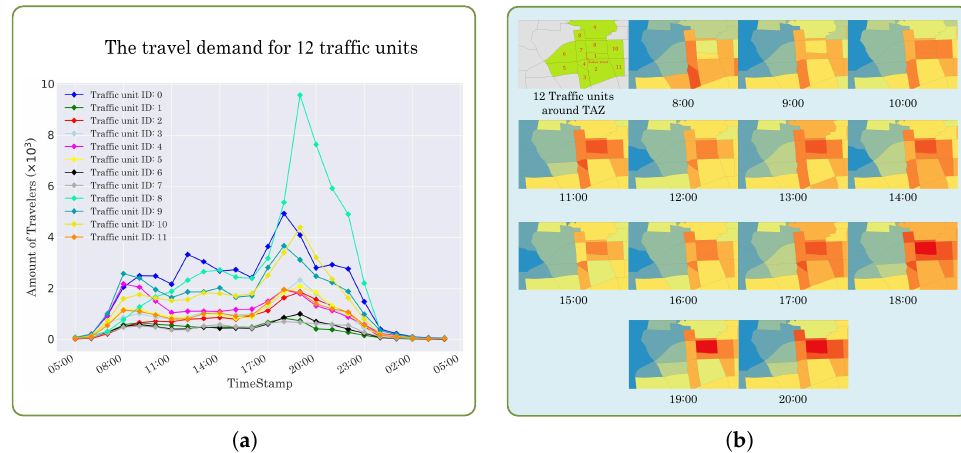
Figure 7. ( a ) The travel demand obtained from cellular data of 12 traffic units around TAZ and ( b ) divide it into 10 categories from 8:00 to 20:00.